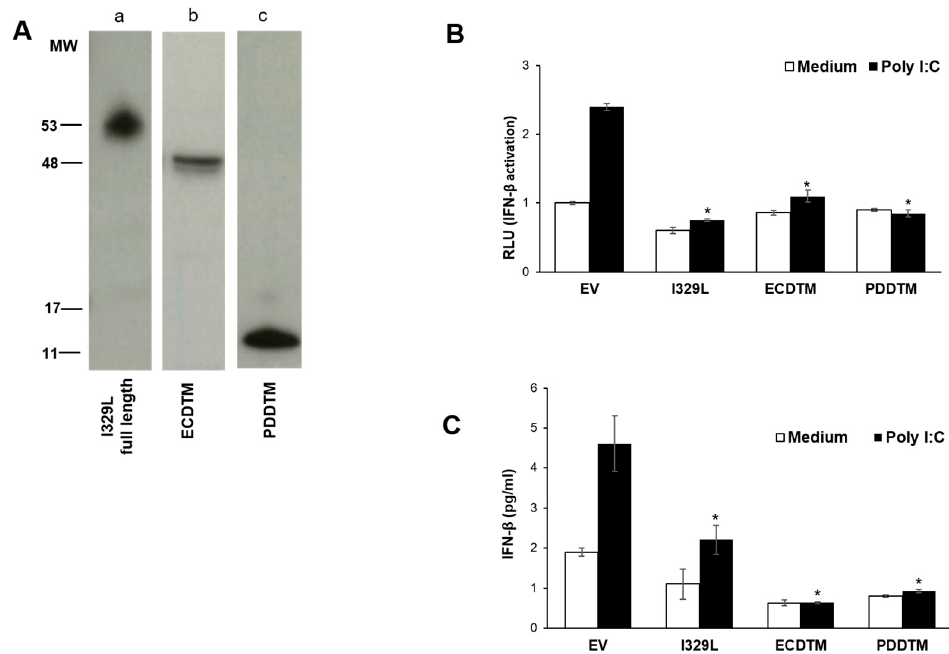
Figure 3. The ECD of I329L inhibits induction and expression of type I IFN. ( A ) HEK-293T cells were transfected with different HA-tagged I329L constructs and expression was confirmed by Western blot using an anti-HA HRP-conjugated antibody: (a) full length I329L, (b) the ectodomain with the transmembrane region (ECDTM), and (c) the putative dimerization domain with the transmembrane region (PDDTM). ( B ) HEK-293T cells were co-transfected with either pcDNA3HA (EV), pcDNA3-I329L-HA, or pcDNA3-ECDTM-HA, the IFN- β luciferase reporter and the β -galactosidase internal control plasmid. Cells were either induced with 25 μ g/mL Poly(I:C) (TLR3 ligand) or left untreated (medium). Luciferase activity was normalized to β -galactosidase activity, and is shown as relative luciferase units (RLU). ( C ) HEK-293T cells were co-transfected with either empty vector pcDNA3HA (EV), pcDNA3-I329L-HA or pcDNA3-ECDTM-HA. At 48 h post-transfection, cells were either stimulated with 25 μ g/mL Poly(I:C) for 5 h, or left untreated (medium). Secreted IFN- β concentration was determined by ELISA. Luciferase activity was normalized to β -galactosidase activity. Data are expressed as means of relative luciferase units (RLU) ± SD of triplicate culture wells and are representative of three independent experiments. RLU and IFN- β secretion ratios quantifying changes between Poly (I:C) treatment vs. untreated conditions for each of the constructs were compared against EV ratios and assessed by Student’s t test. * p ≤ 0.05.